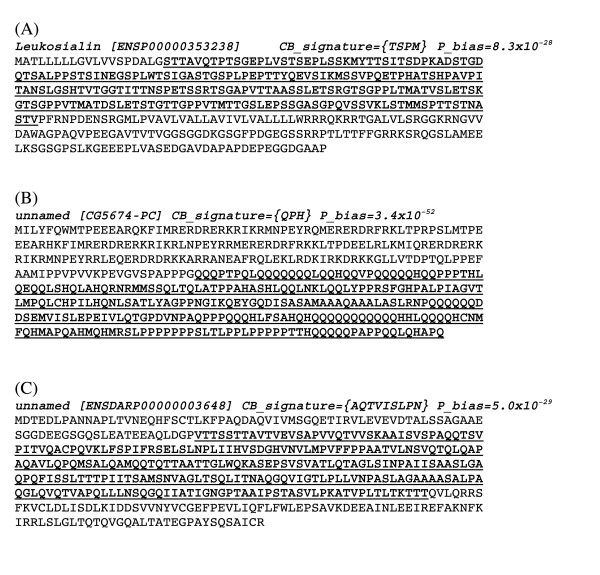
Examples of assigned CB regions. In each case, the name of the protein, its current Ensembl identifier, its CB signature and Pmin value are indicated. The CB region is in bold and underlined; the rest of the sequence is in plain text. The proteins are as follows: (A) leukosialin from the human protein, (B) and unnamed fruitfly protein and (C) an unnamed chicken protein.